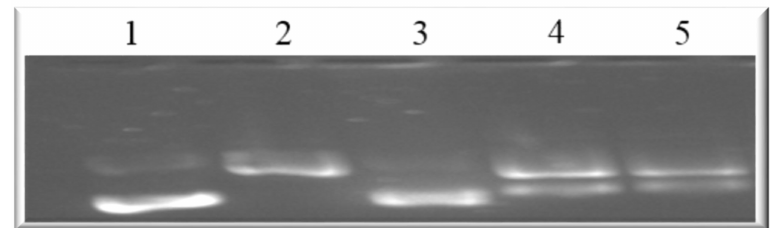
Figure 10. Agarose gel showing the DNA relaxation e ff ects of holamine and funtumine on topoisomerase-I. Lane 1 represents supercoiled DNA; lanes 2, 3, 4 and 5 represent supercoiled DNA and with topoisomerase-I (2 U), camptothecin (9.3 mg / mL), and 15 µ g / mL of holamine and funtumine,